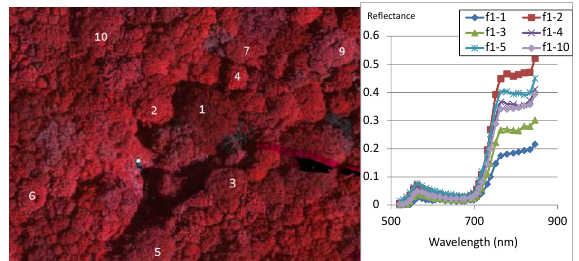
Figure 10. Preliminary spectra from morning flights.